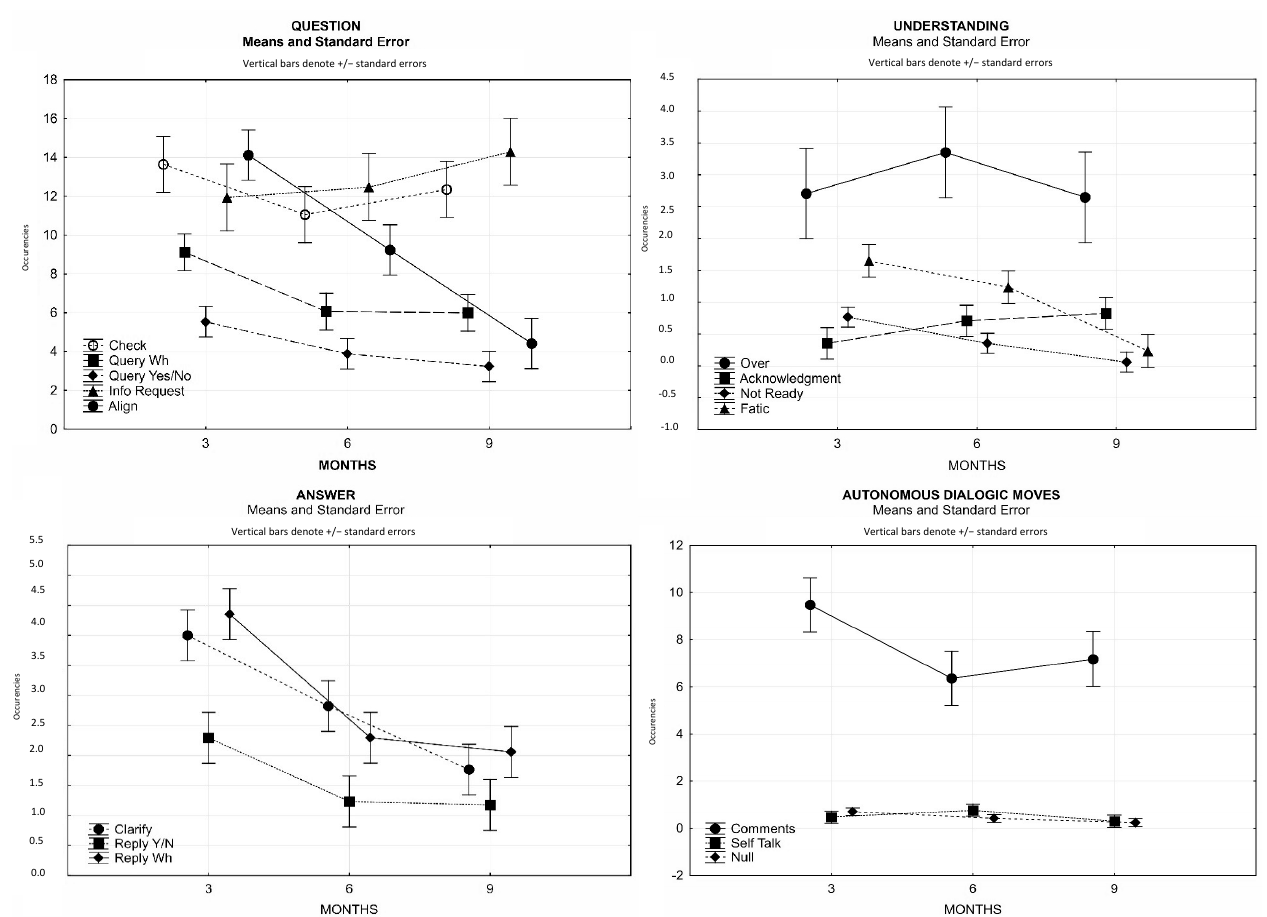
Figure 7. Means and standard error of Pra.Ti.D codifications at three, six, and nine months.